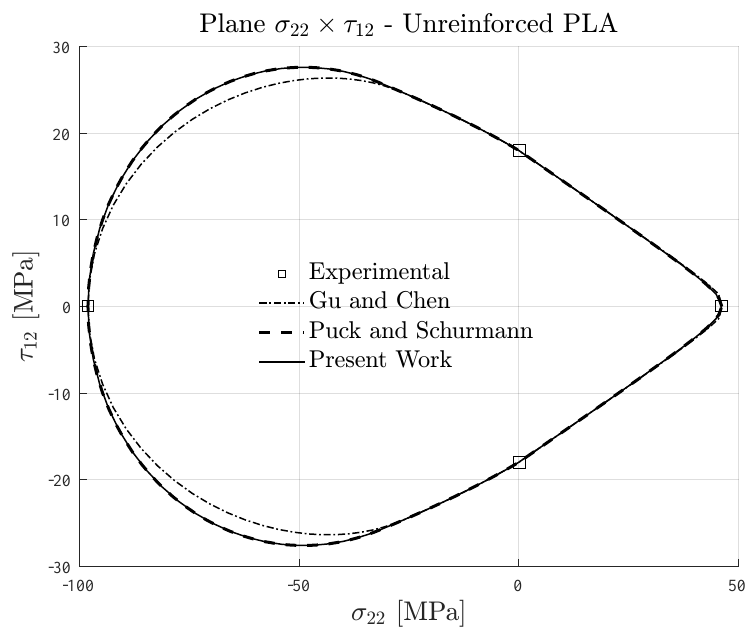
Figure 12. Failure envelopes on the stress space σ 22 × τ 12 for unreinforced 3D-printed PLA. Inclination parameters p c ⊥⊥ = 0.53 for Puck and Schürmann and Expanded Puck and Schürmann.